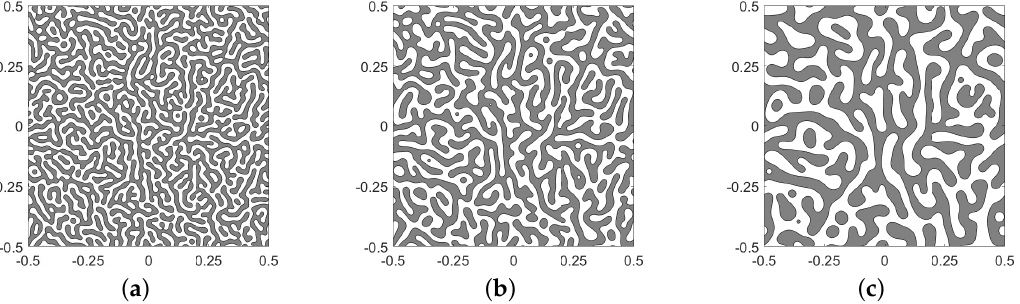
Figure 9. ( a – c ) are the snapshots of numerical solutions of the Cahn–Hilliard (CH) equation with the initial condition (39) using the Fourier-spectral method at t = 100 ∆ t , 300 ∆ t , and 1000 ∆ t , respectively.